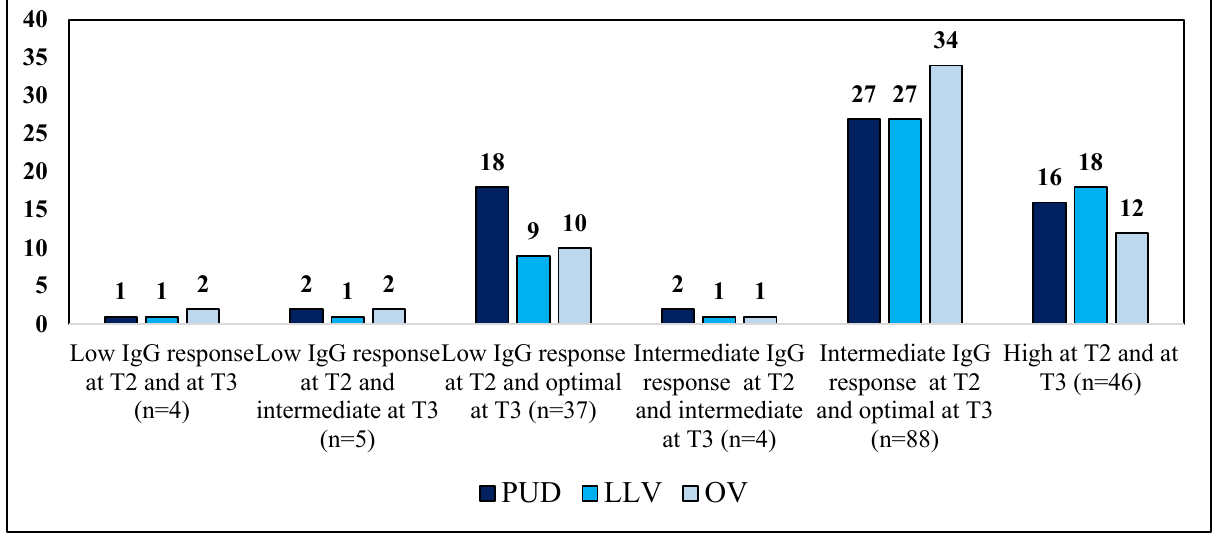
Figure 3. Description of the frequency of patients with PUD, LLV and OV in the different combinations of IgG response modification from T2 (6 months after the second vaccine dose) to T3 (six months after the third vaccine dose). PUD: plasma HIV viremia persistently undetectable; LLV: low-level viremia, no plasma HIV-RNA value was >20 copies/mL; OV: ongoing viremia, if at least